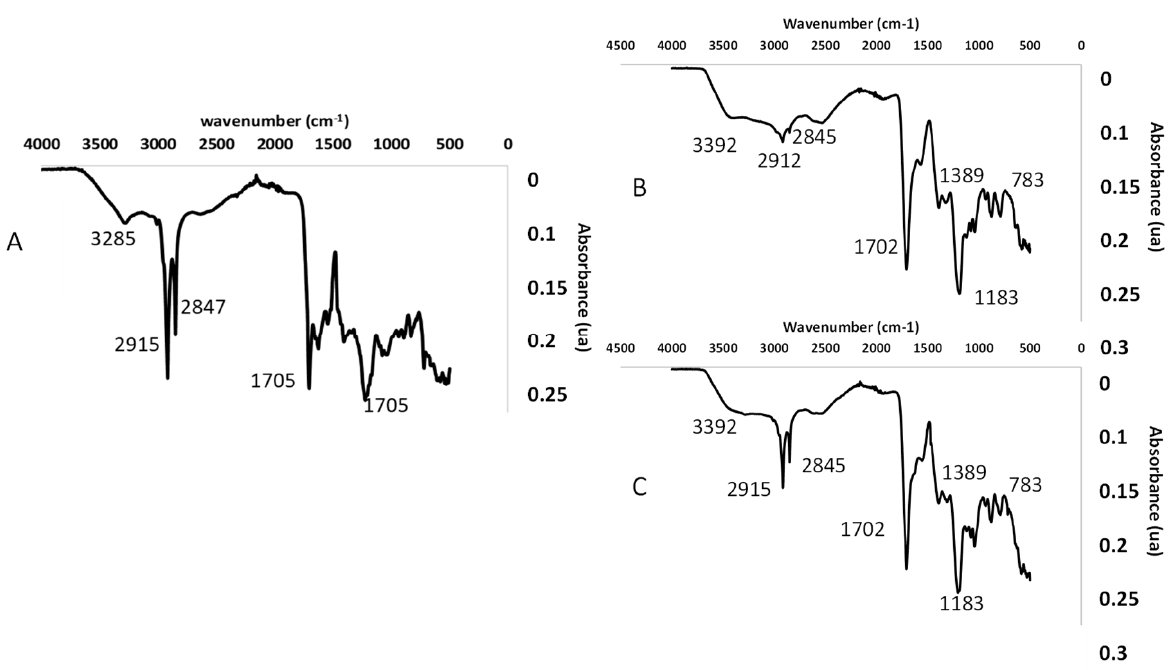
Figure 4. FTIR spectra of UAE cutin samples from tomato ( A ) watermelon ( B ) and apple ( C ) peels.